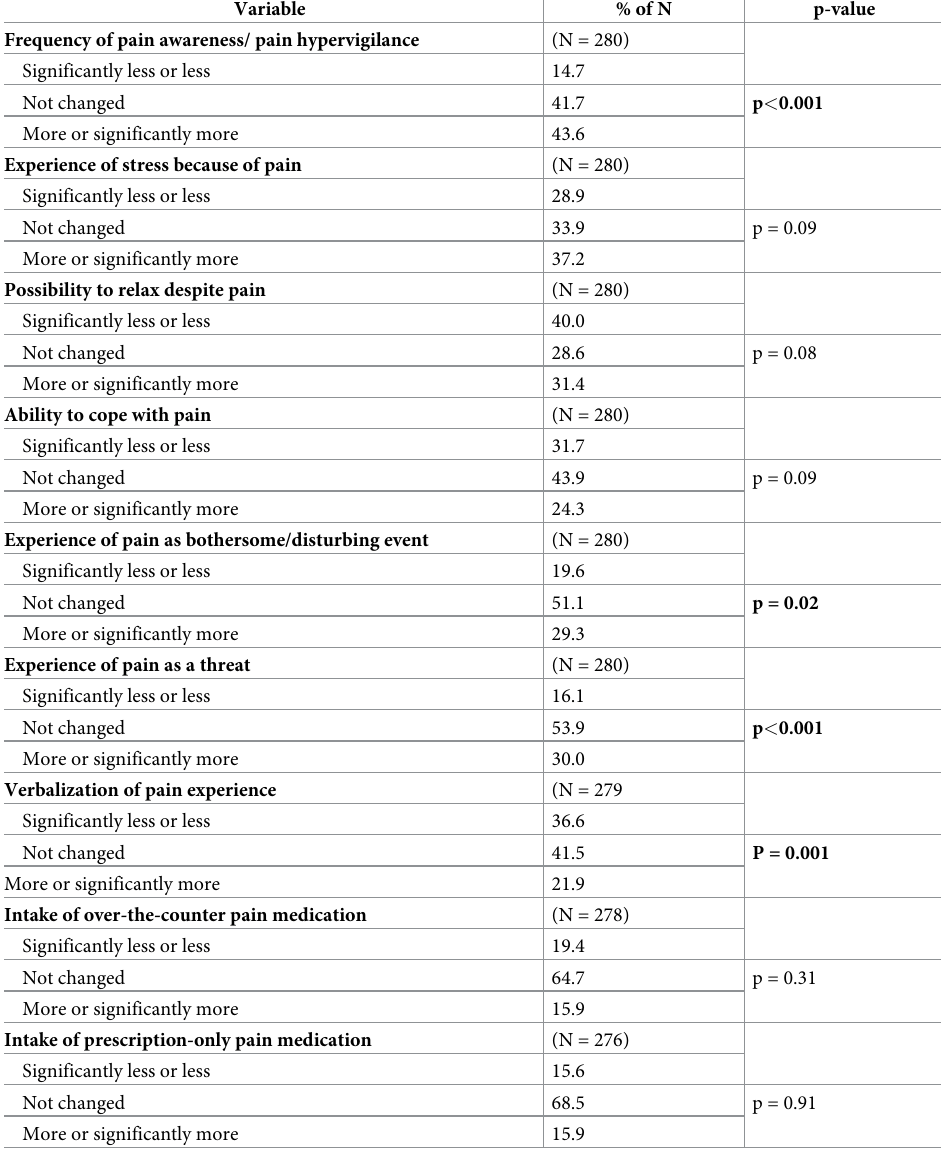
Table 6. Alterations in pain perception and medication during social isolation or